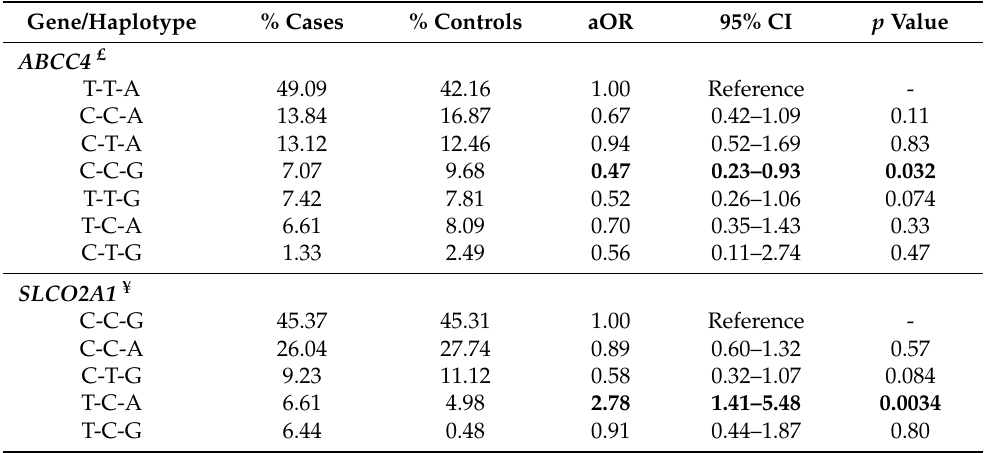
Table 3. Haplotype frequencies between patients and controls and risk estimates for their involvement in gastric cancer